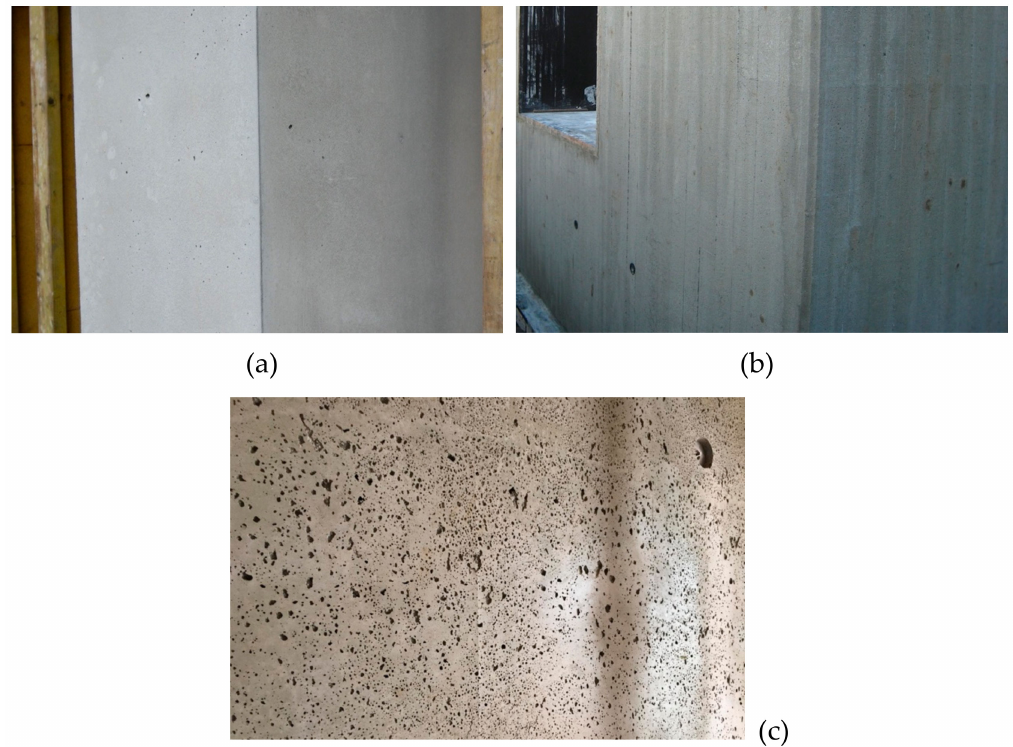
Figure 11. Surface texture of executed ILC projects. Perfectly smooth surface ( a ); rough saw surface ( b ); porous (vivid) surface ( c ) (courtesy: Björn Callsen and Werner Rothenbacher)